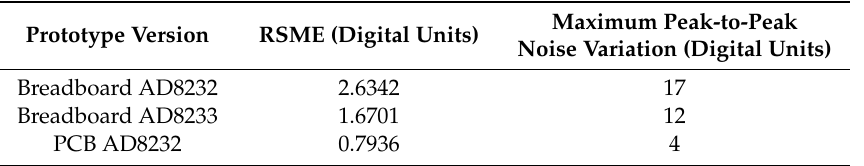
Figure 15. Noise output test when the electrode inputs are tied together. ( a ) Breadboard with the AD8232 AFE microchip; ( b ) Breadboard with the AD8233 AFE microchip; ( c ) PCB with the AD8232 AFE microchip. The left side illustrates the amplitude plots for each sample. The right side displays the statistical histogram of the test. Table 11. RMSE and peak-to-peak variation of the digital output when shorting the +IN and –IN electro inputs pins.